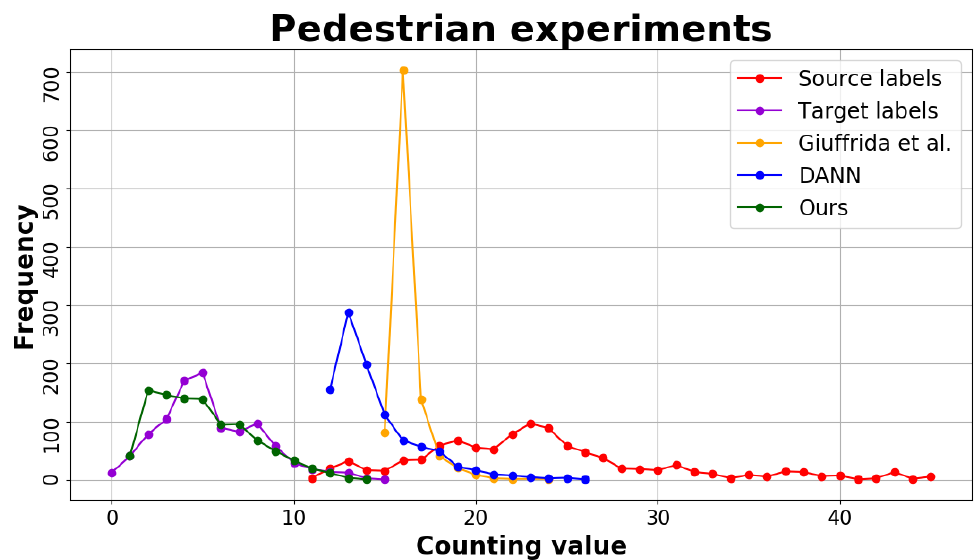
Figure 4. Histogram visualisation of counting frequencies in Pedestrian experiments. (Best viewed in